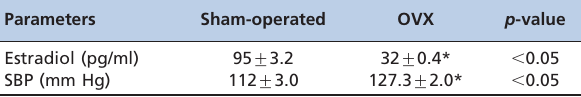
Table 1 - Plasma estradiol levels and systolic blood pressure (SBP) in the two studied groups of mice.